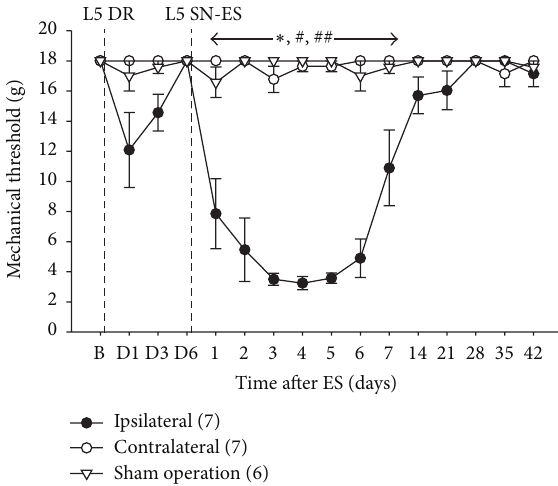
Figure 2: Tactile hypersensitivity following tetanic ES of the decentralized L5 SN. A tetanic ES of the L5 SN (L5 SN-ES) in rats with L5 DR induced a significant decrease in PWTs in the affected hind-paws on days 1 through 7 after ES compared with the baseline, contralateral hind-paws, and sham-operated animals. The abbreviations B and D denote the baseline before DR and postoperative days after DR, respectively. The figures in parentheses indicate the number of animals used. The error bars represent the SEM. ∗ 𝑃 < 0.05 versus sham animals. # 𝑃 < 0.05 versus baseline. ## 𝑃 < 0.05 versus contralateral